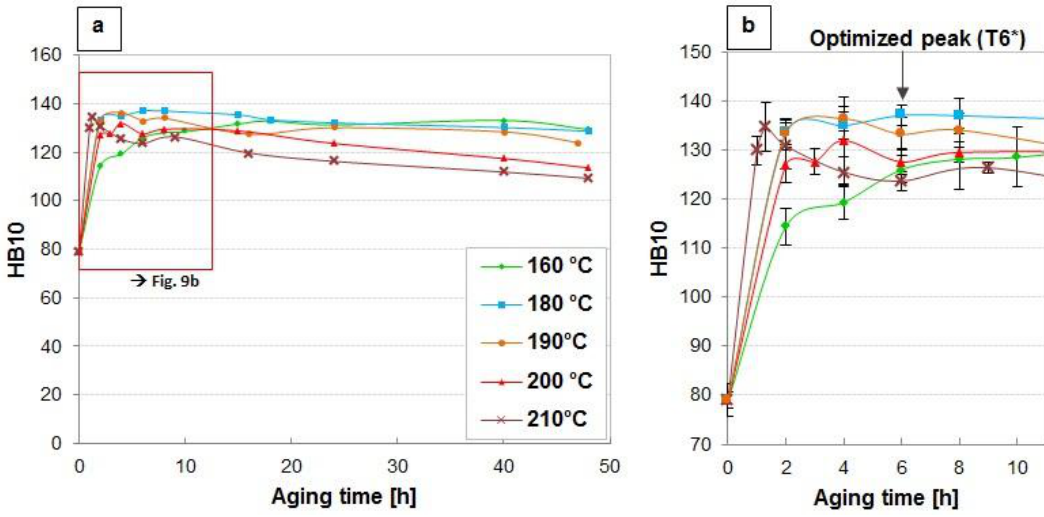
Figure 9. Aging curves of A354 alloy show the evolution of Brinell hardness with aging time. The samples were solution treated at 495 °C–6 h, then 515 °C–2 h, water quenched (60 °C) and aged at 160, 180, 190, 200, and 210 °C for up to 48 h, ( a ) Focus on the first aging hours ( b ). This is readapted from Reference [21].